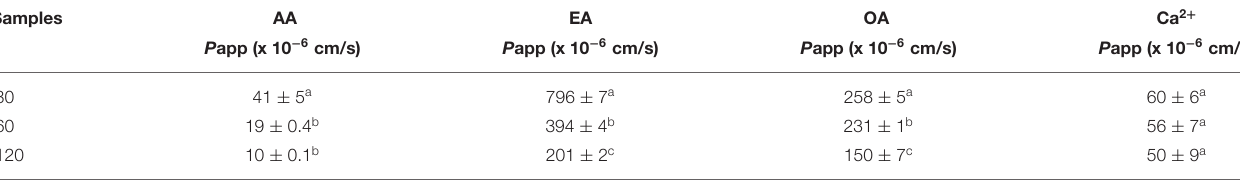
TABLE 2 | Apparent permeability ( P app) of AA, EA, OA, and calcium (Ca 2 + ) from T. ferdinandiana digesta.